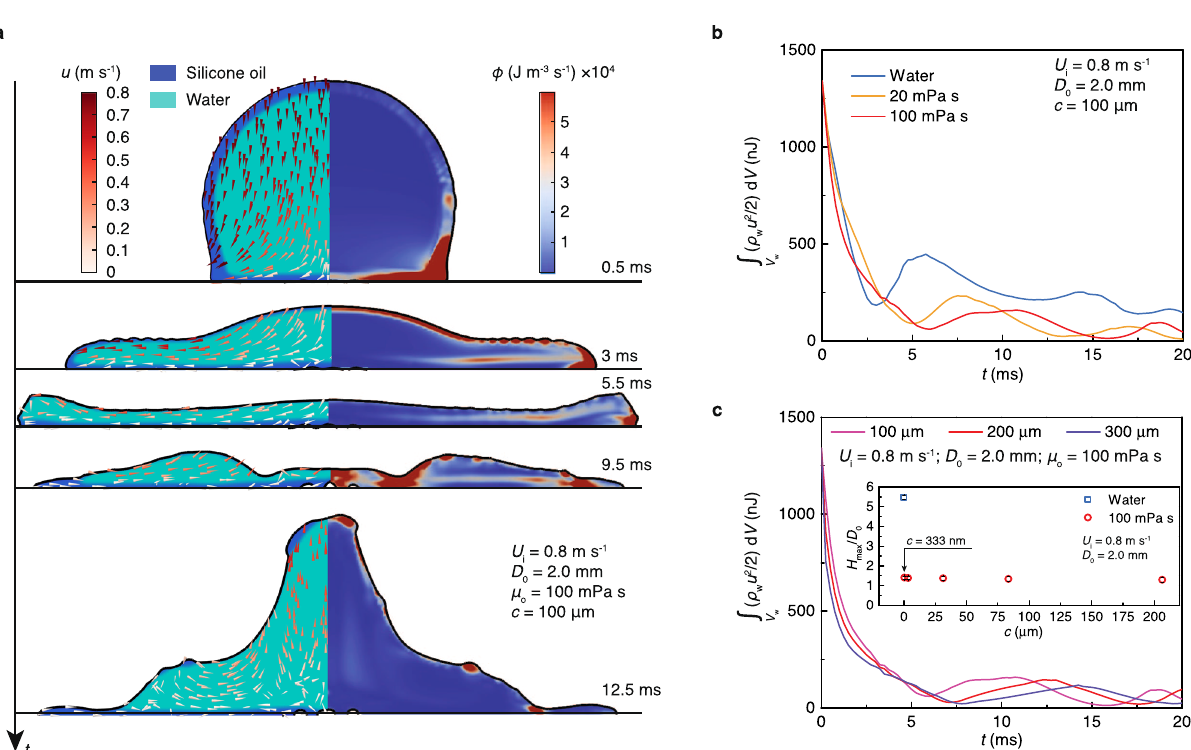
Fig. 3 Viscous damping. a Numerically calculated phase, fl ow fi eld and distribution of the viscous dissipation rate of an impacting overlaid droplet. Viscous dissipation centralises in the overlayer and abounds in the spreading stage. Numerically calculated evolution of the kinetic energy of the water core during the impact for different ( b ) viscosities and ( c ) thicknesses of the overlayer. The inset in ( c ) shows that the experimental maximum out-of-plane height appears nearly independent of thickness for the range of 0.333 < c < 206 μ m, and the error bars denote the standard deviation over three experiments. The overlayer effectively suppresses the rebound as its thickness is as thin as c ~333